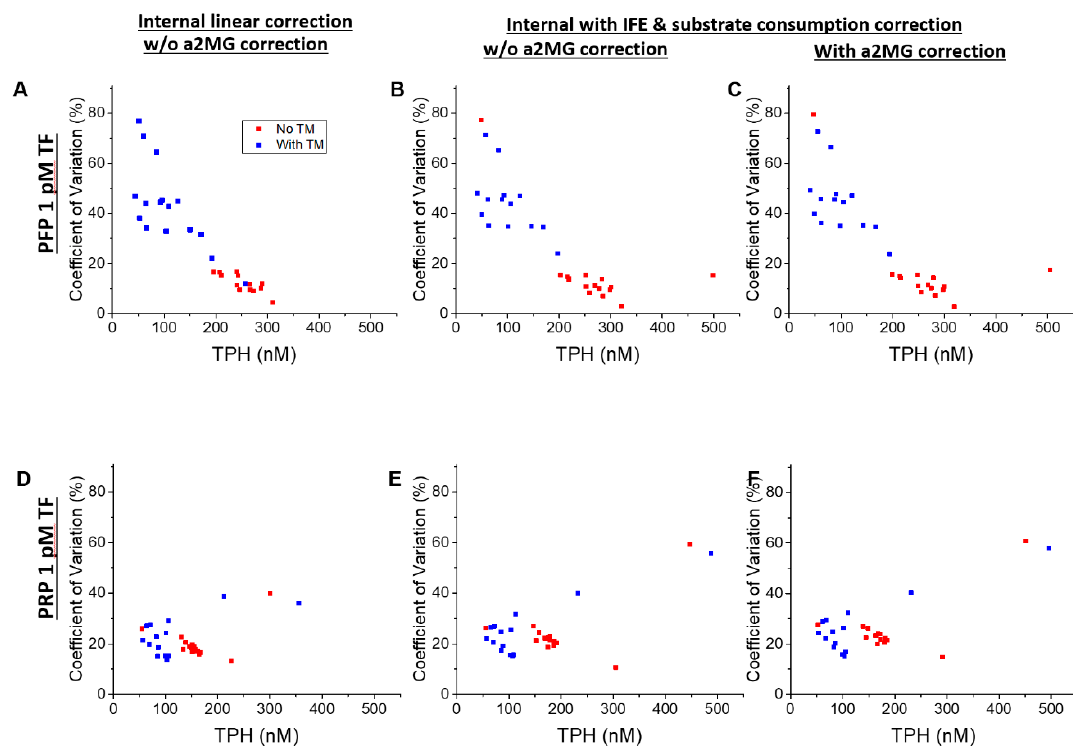
Figure 6. Correlation between run-to-run variation and TPH. Coefficients of variation (CVs) between runs of the same condition were calculated and plotted against the average TPH for their respective conditions. Each dot represents a single experimental condition (normal plasma plus coagulation factor). Conditions with added TM are plotted in blue; conditions without added TM are plotted in red. ( A – C ) PFP 1 pM TF; ( D – F ) PRP 1 pM TF. ( A , D ) internal linear correction; ( B , E ) internal nonlinear correction (i.e., IFE and substrate consumption corrections); ( C , F ) internal nonlinear and T- α 2MG corrections.